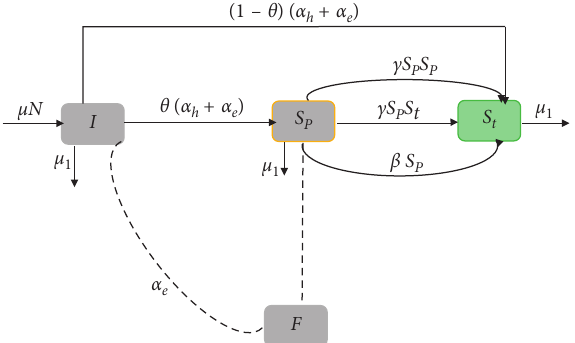
Figure 1: Description diagram of the rumor dynamics.